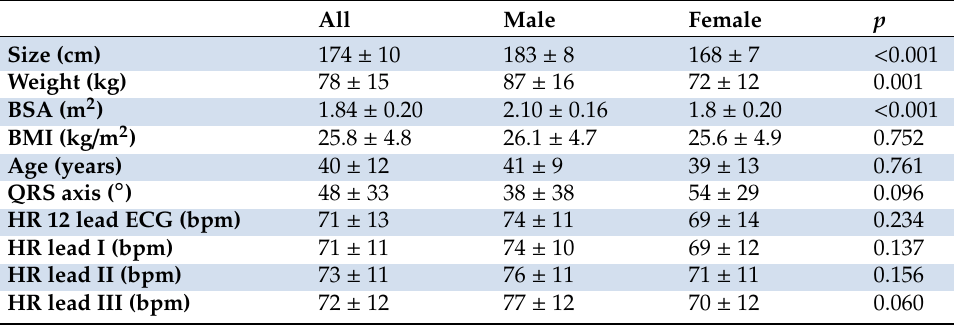
Table 1. Subject characteristics (BSA = body surface area, BMI = body mass index, HR = heart rate). P values were obtained by T-Test and ANOVA; probability limit